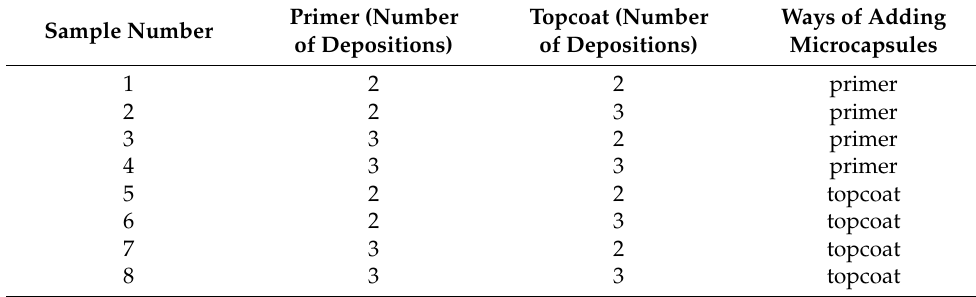
Table 2. Experimental schedule of coating technology.